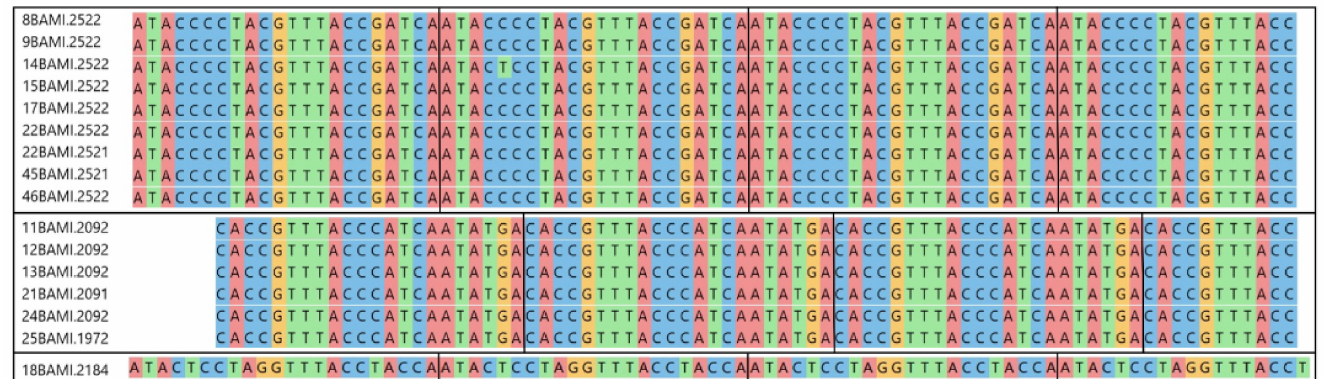
Figure 2. Clustal alignment of the three different TR motifs identified. Each of the upper two boxes comprises isolates with identical TR sequences, except for one nucleotide substitution in 14BAMI.2522. The lower box shows one further TR represented by a single isolate only. Vertical black lines indicate the end of a single repeat. The TR size is 22 nt, and the copy number ranges from 3.5 to 3.9.